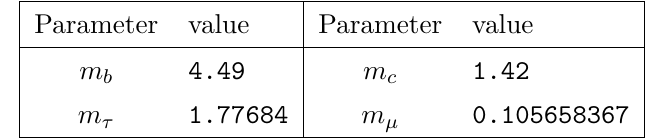
Table 6. Light-fermion masses given in inputs to SMWidth .